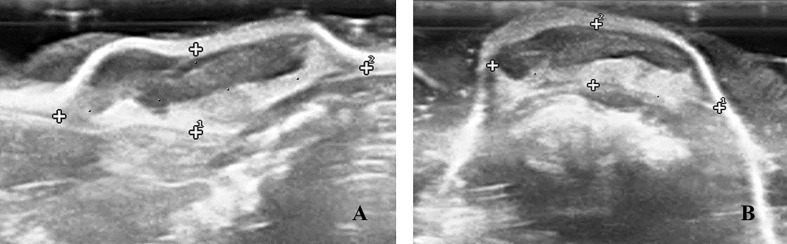
B-mode ultrasound images of Ehrlich Solid Carcinoma induced in the subcutaneous tissue of Swiss albino mouse, showing in (A) Longitudinal view showing the measurements of length and height. (B) Cross-sectional view showing width and height measurements. 18 MHz transducer.